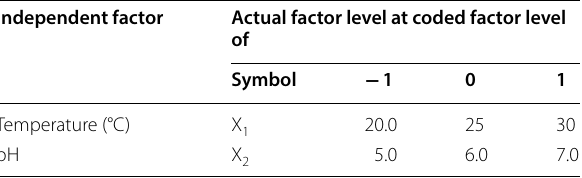
Table 1 Optimalization of physical parameters for the protein yeast biomass production: independent variables in a 2 2 full factorial experiment design